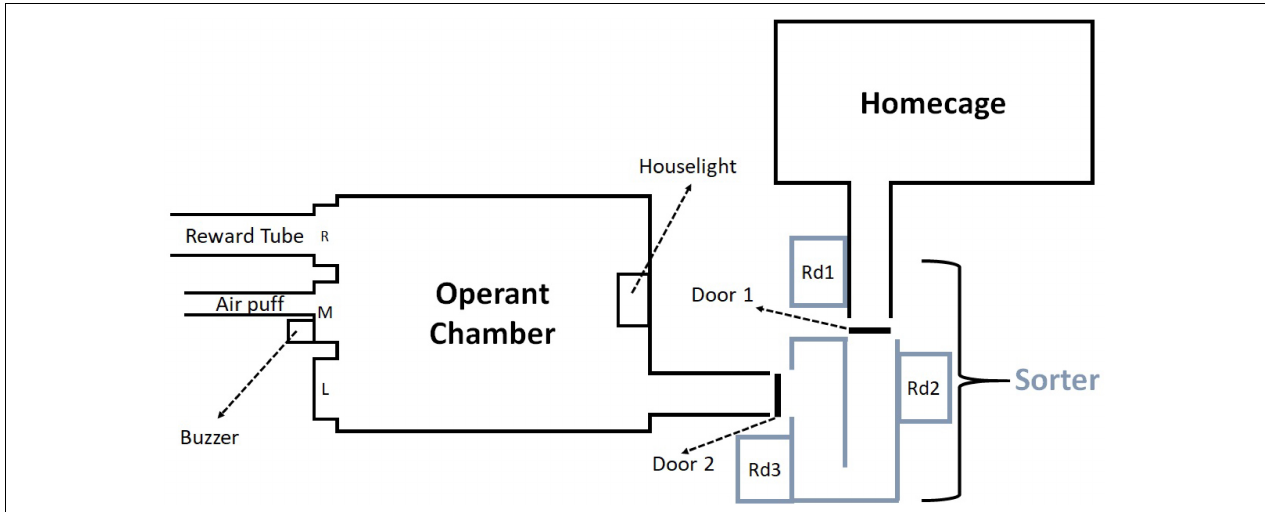
FIGURE 1 | The automated dual cage system consisted of three parts: a home cage, a sorter and an operant chamber. The sorter connected the operant chamber and home cage. When reader (Rd) 1 detected a mouse door 1 opened, and when the mouse had proceeded to reader 3 door 1 closed. Both doors remained closed for 30 s to verify that only a single mouse was inside the sorter. Afterward, door 2 opened and the mouse proceeded to the operant chamber for a session (30 min). The operant chamber contained three ports with nose-poke sensors (L: left, M: middle, R: right), a 4.5 kHz buzzer used for the stop signal and a house light to signal timeout. L and M were used as response ports, R was used as a reward port. A metal tube within M could deliver air puffs to negatively reinforce responses after a stop signal. A pellet feeder delivered pellets to